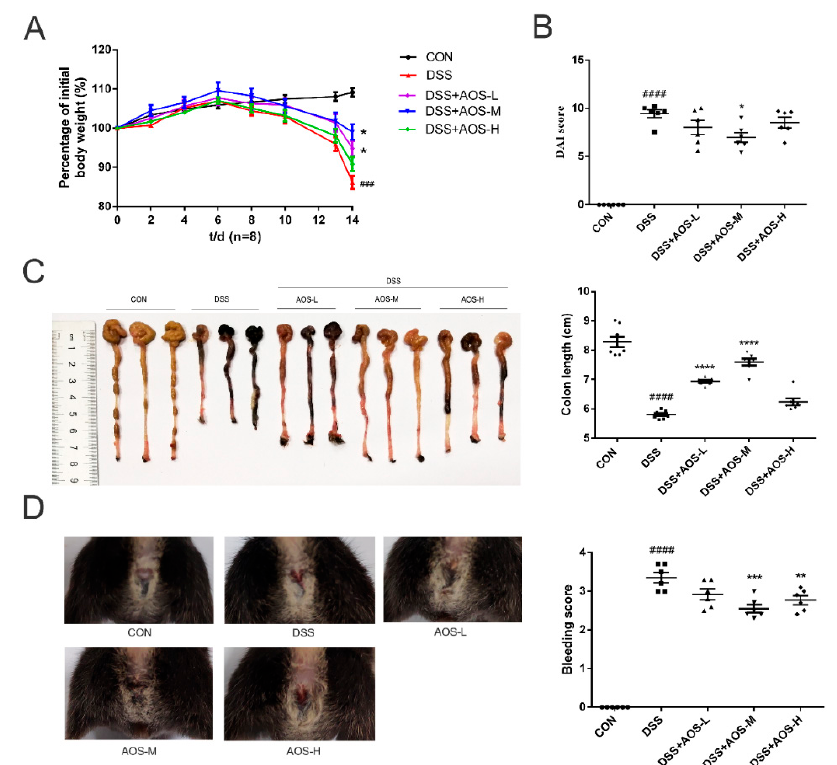
Figure 2. Effects of oral AOS administration on DSS-induced colitis in mice. The mice were gavaged with either PBS or AOS daily for 14 d, and colitis was induced from Days 8 to 14 by adding DSS (2.5% w / v ) to sterile drinking water. ( A ) Changes in body weight. ( B ) Changes in DAI score. ( C ) Changes in colon length. ( D ) Changes in rectal bleeding. * p < 0.05, ** p < 0.01, *** p < 0.001, **** p < 0.0001 vs. DSS group; ### p < 0.001, #### p < 0.0001 vs. Control; (n = 6).